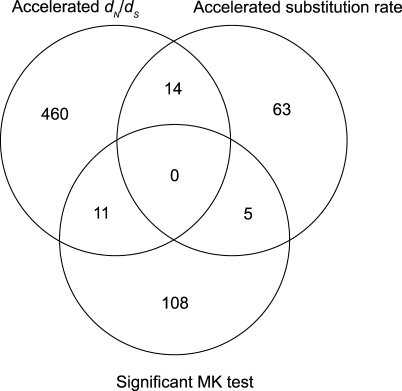
Venn Diagram Showing Overlap between Three Different Subsets of Fast-Evolving GenesGenes with evidence for accelerated dN/dS on the human lineage based on a LRT p<0.05 using a chi-squared test are shown in one circle. Genes containing exons with evidence for accelerated evolutionary rate in humans based on simulations with a FDR p < 0.05 are in the second circle. Genes with evidence for a significant McDonald-Kreitman test [39] with p < 0.05 are in the third circle.